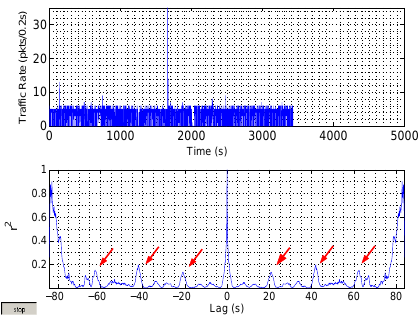
Figure 20: Detecting DSSS Marks Using Single- Flow Attack over Tor